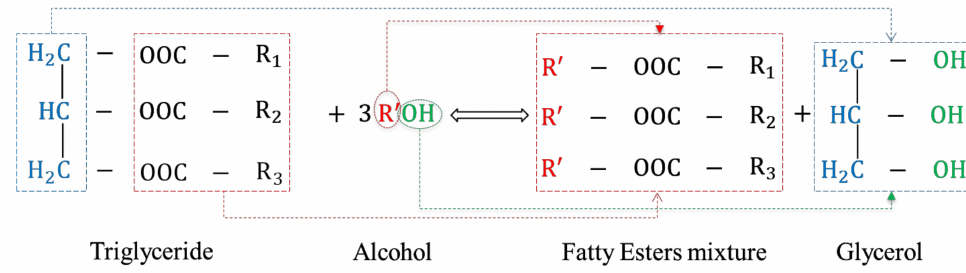
Figure 1. The transesterification reaction mechanism.